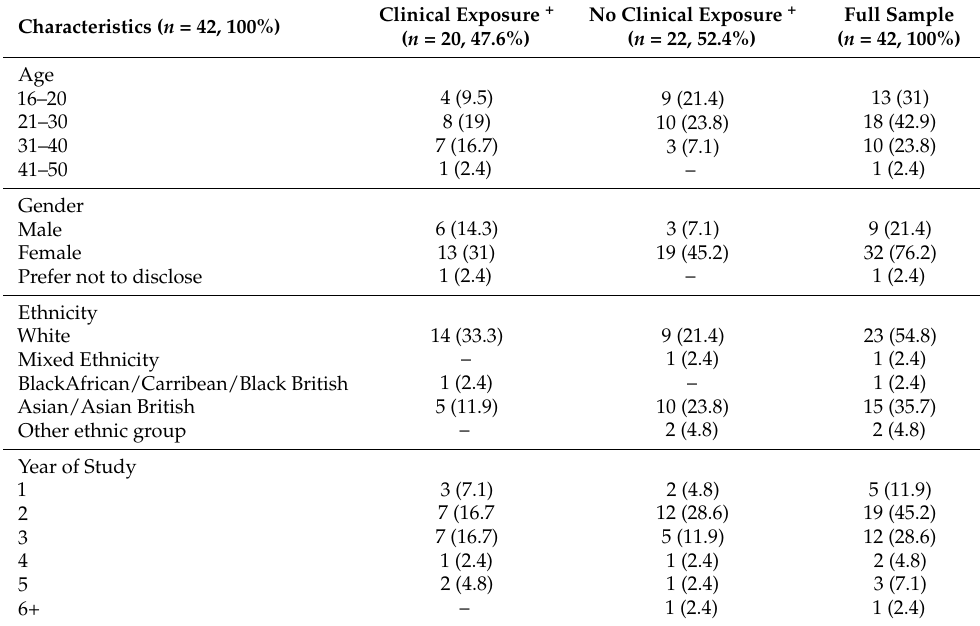
Table 1. Participant Characteristics by Clinical